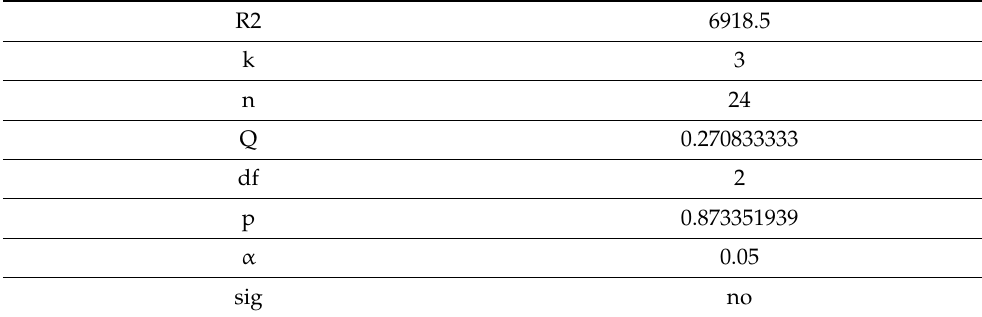
Table 3. Friedman’s test results.